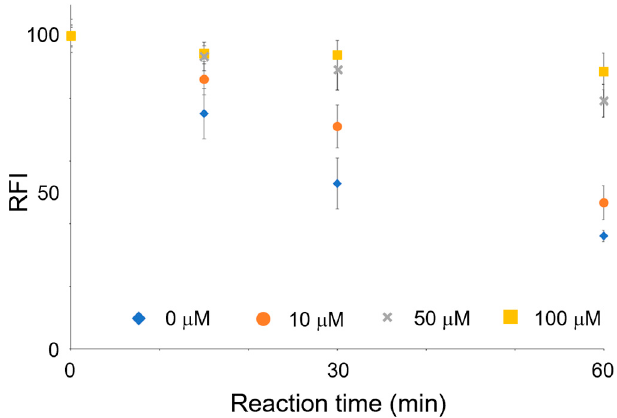
Figure 6. The inhibition effect of 5-fluoroorotic acid on FL production. OPRT activity was restricted by the inhibitor, resulting in diminished consumption of orotic acid. All experiments were repeated three times on different days.